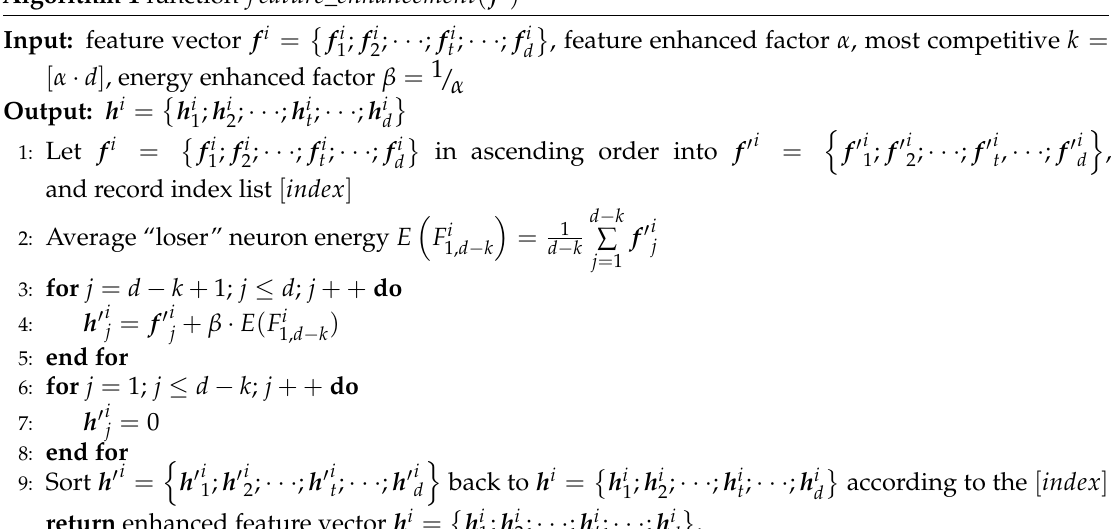
Algorithm 1 function f eature _ enhancement ( f i )